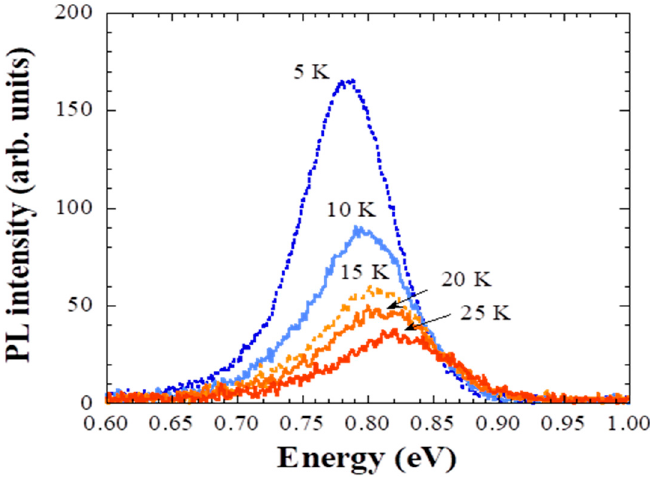
Figure 2. PL (photoluminescence) spectra at cryogenic temperatures.